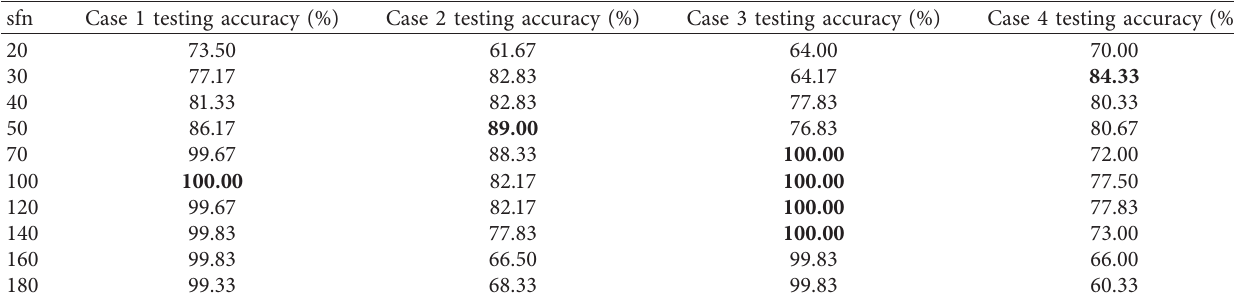
Table 20: Bearing fault diagnosis results obtained by the OFS-TSFRS-LMMC-SVM.